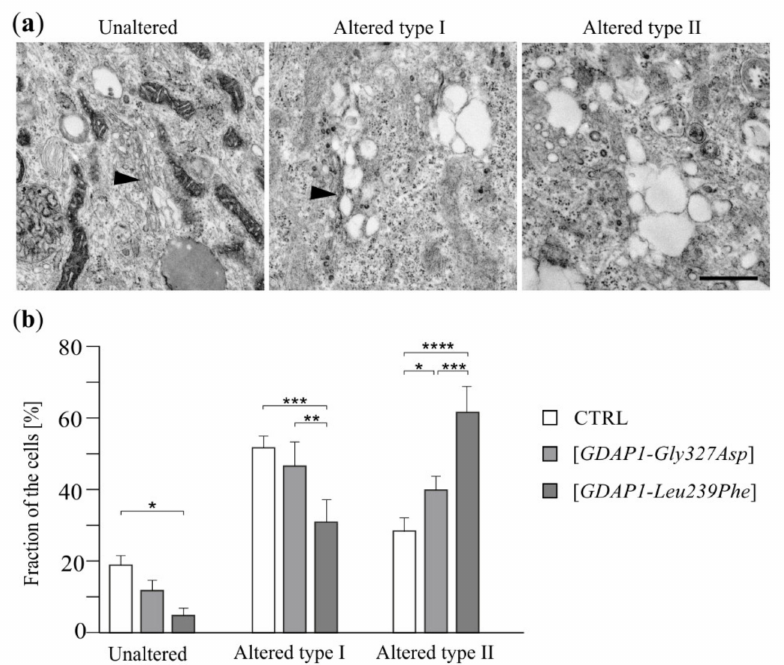
Figure 3. Expression of mutant GDAP1 variants affects the morphology of the Golgi in HeLa cells. ( a ) Transmission electron microscope analysis of the Golgi in non-transfected HeLa cells (CTRL) or in HeLa cells transfected with a vector carrying GDAP1-Gly327Asp or GDAP1-Leu239Phe alleles. Electron micrographs of representative examples of Golgi structures observed in HeLa cells. Black arrowheads indicate the cisternae of the Golgi. Scale bar 750 nm. ( b ) Fraction of cells [as percentage of counted cells] with types of Golgi ultrastructure indicated. Statistical analysis was performed on data from three independent experiments using one-way ANOVA and Bonferroni’s correction: